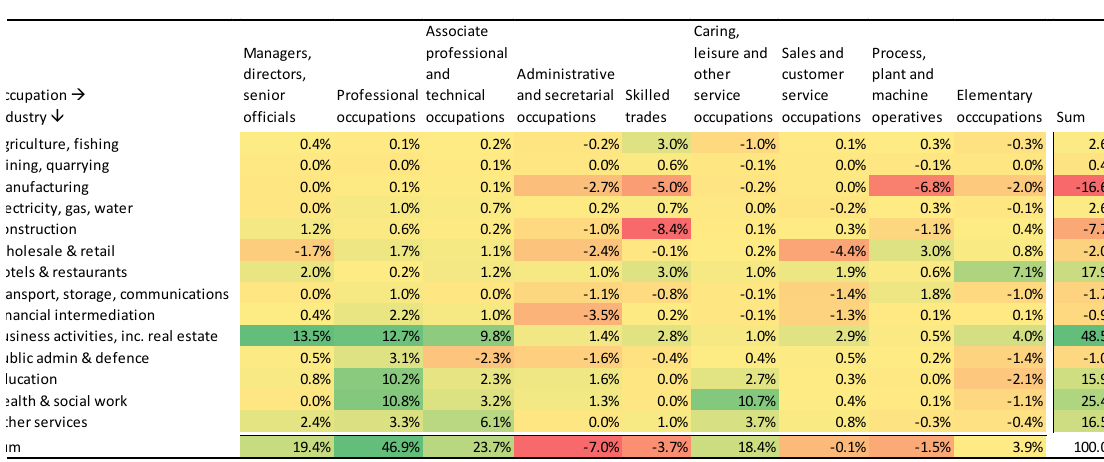
Source: RF analysis of ONS, Labour Force Survey